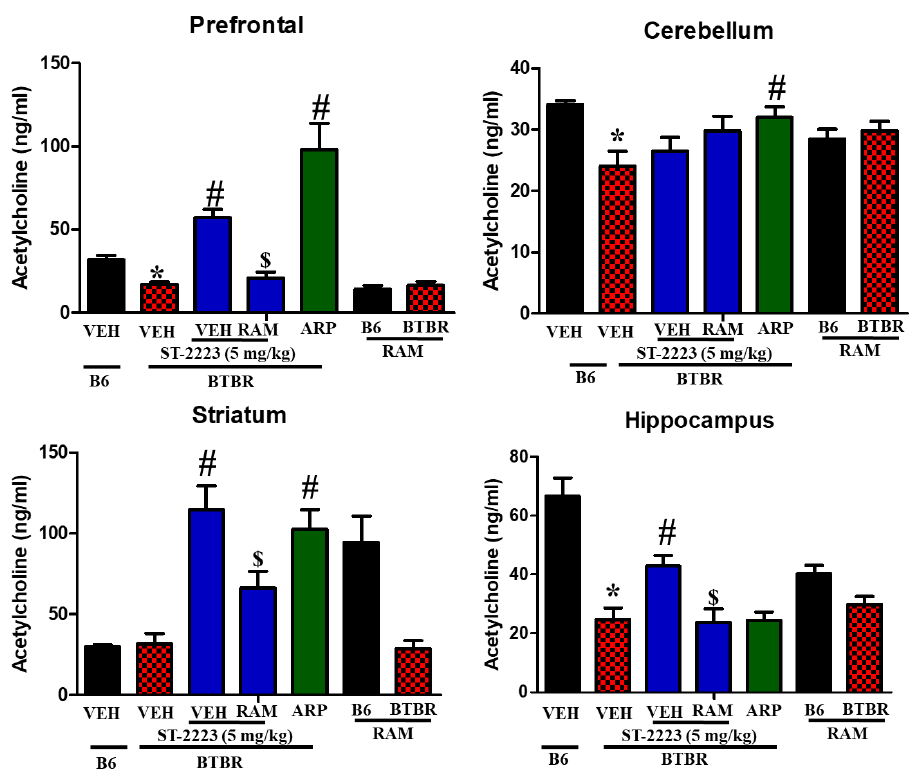
Figure 6. Estimation of acetylcholine levels by LC-MS/MS in different brain regions of BTBR. * p < 0.05 compared to VEH-treated B6 mice. # p < 0.05 compared to VEH-treated BTBR mice. $ p < 0.05 compared to ST-2223-(5 mg)- treated BTBR mice. Data are expressed as the mean ± SEM (n = 5). Table 2. Summary of the multiple effects provided by ST − 2223 on the levels of neurotransmitters quantified by LC-MS/MS in different regions of BTBR mice brain. BTBR Mice